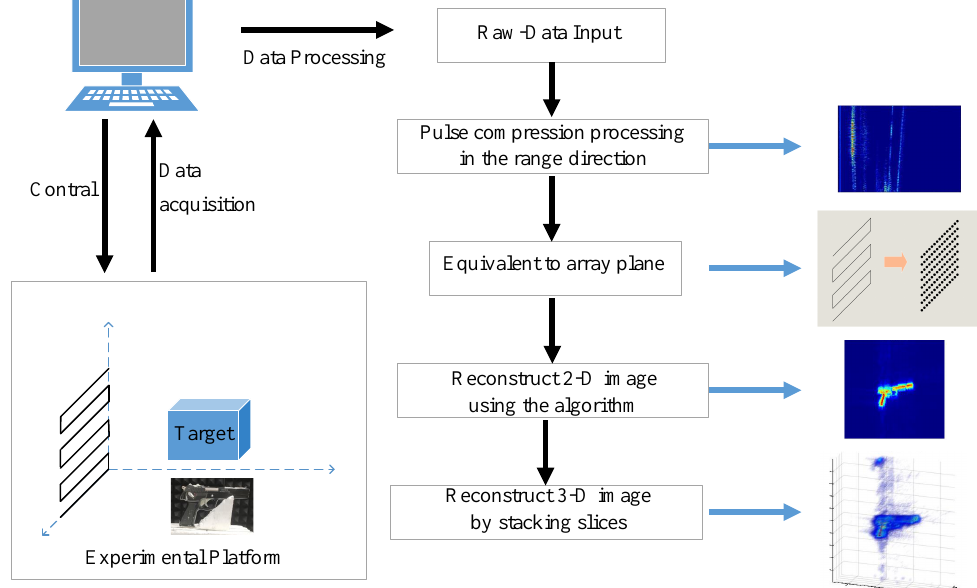
Figure 1. The framework of 3-D MMW data acquisition and